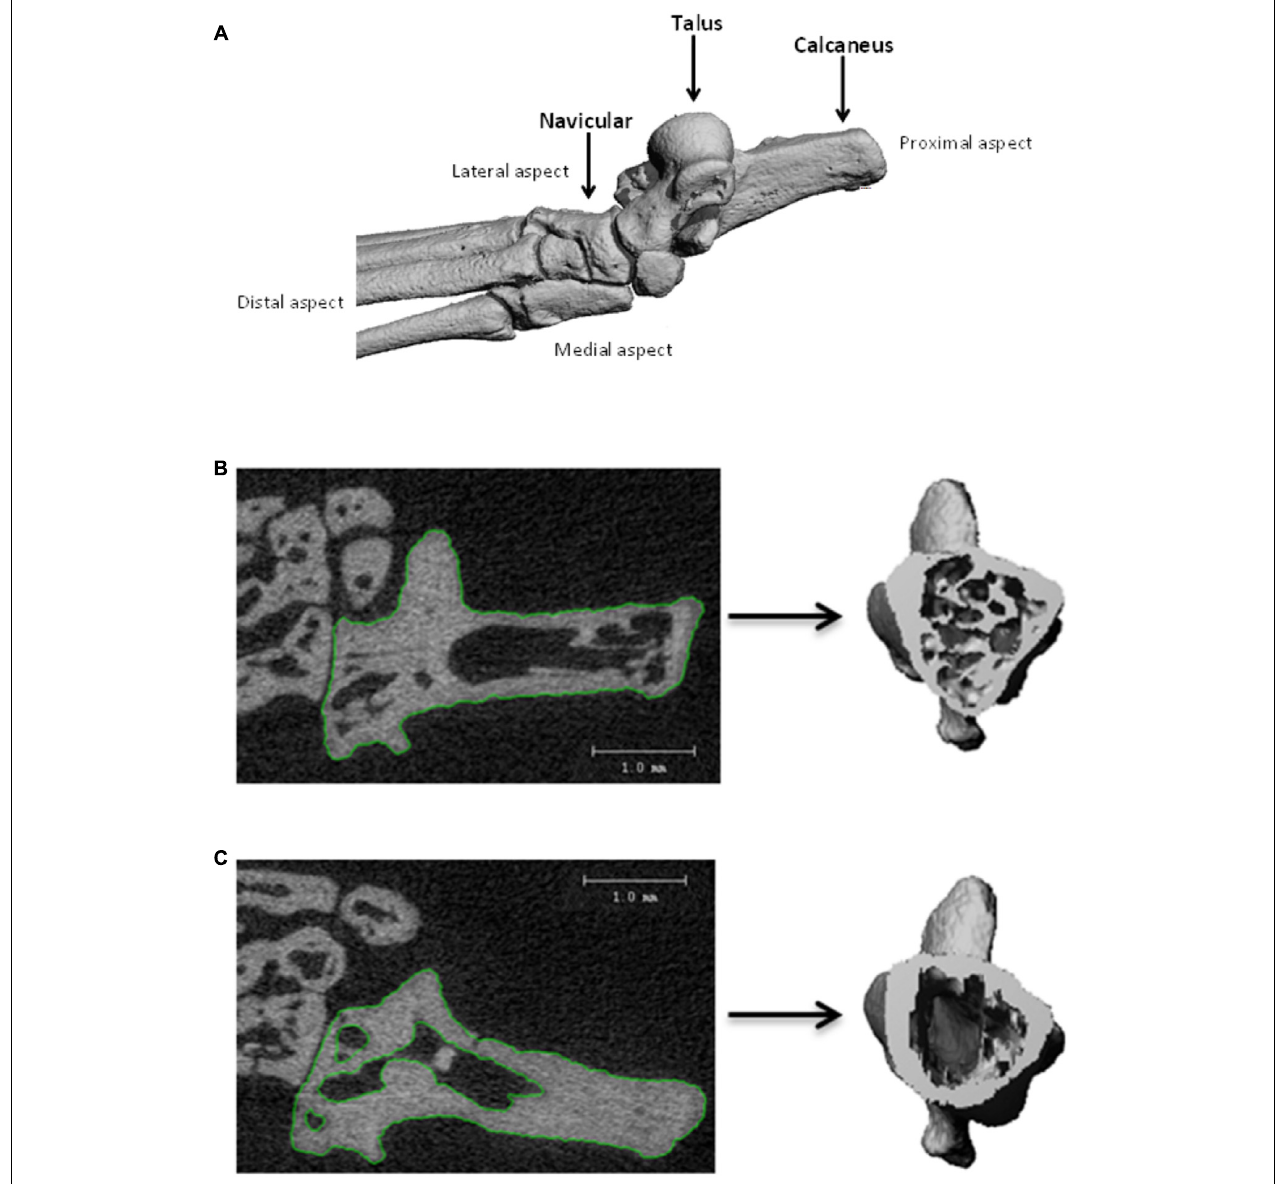
FIGURE 1 | Three-dimensional reconstructions of the ankle bones (A) . Contouring of 2D projection images to produce 3D reconstruction, for: (B) single contouring for total bone analysis; (C) double contouring for cortical bone analysis.